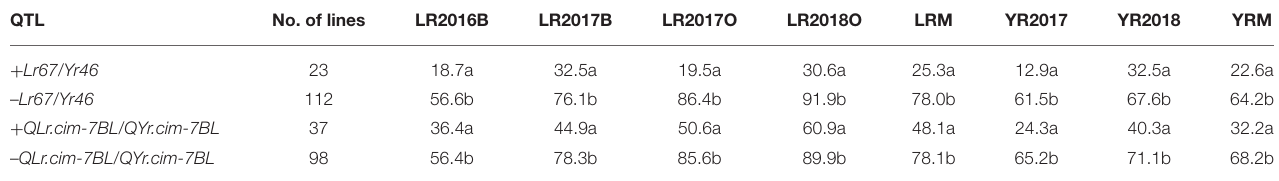
TABLE 5 | T -tests for the comparison of MDS for leaf rust and stripe rust in KU3067 × Apav BILs with and without the resistance alleles.